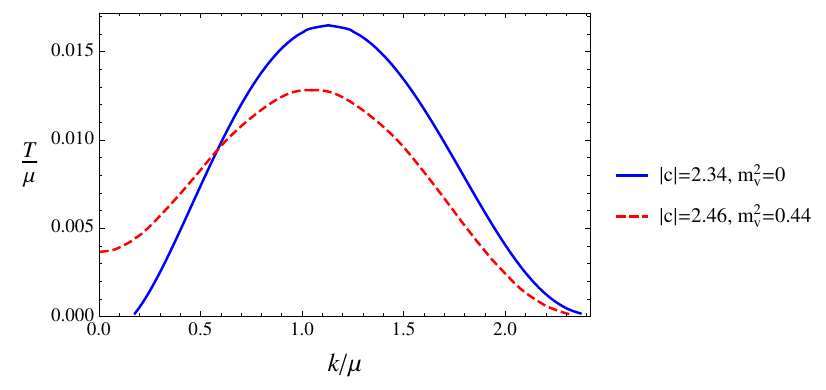
Figure 1 . Critical temperature versus wave number for the onset of striped instabilities for the massless case (solid line) and massive case (dashed line). The peaks are located at ( k (cid:25) 1 : 130 (cid:22); T (cid:25) 0 : 01649 (cid:22) ) for the solid curve and at ( k (cid:25) 1 : 048 (cid:22); T (cid:25) 0 : 01281 (cid:22) ) for the dashed one. The remaining parameters are m 2 = (cid:0) 8 ; L = 1 = 2 ; a = 4 ; (cid:20) = q A =